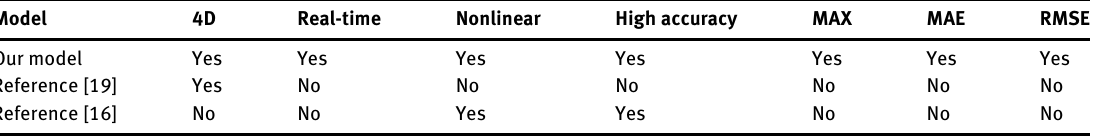
Table 3: Comparison of Different Models.